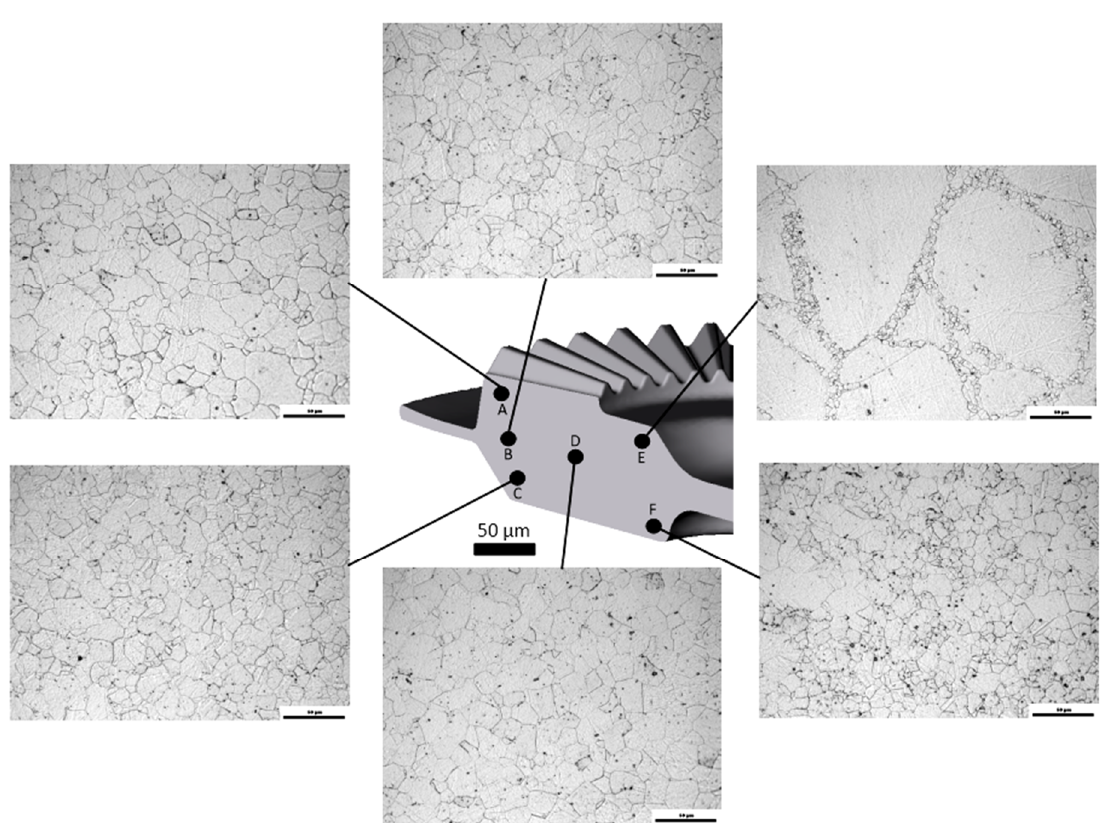
Figure 10. The microstructure of the Waspaloy forged part observed at various areas of its cross-section (areas marked from A to F ).